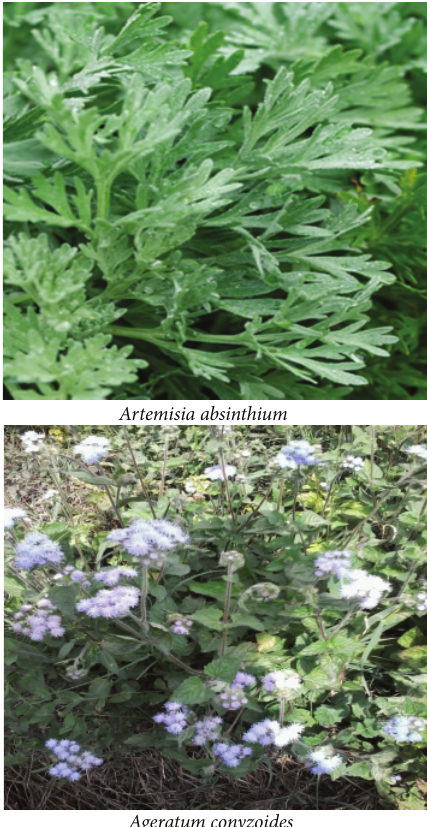
Figure 1: Plants used for extract